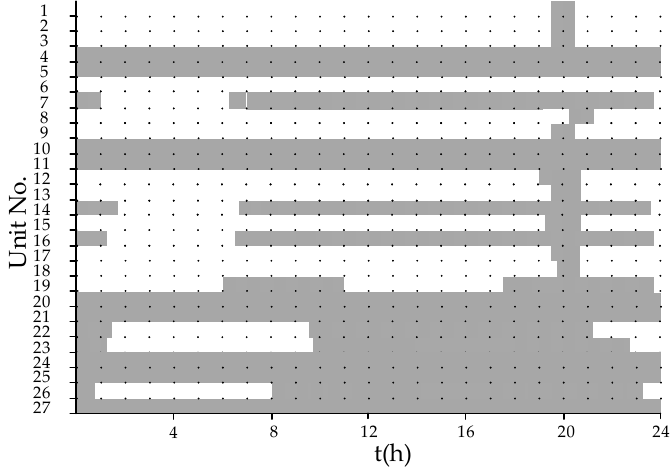
Figure 7. Unit commitment of partial units.